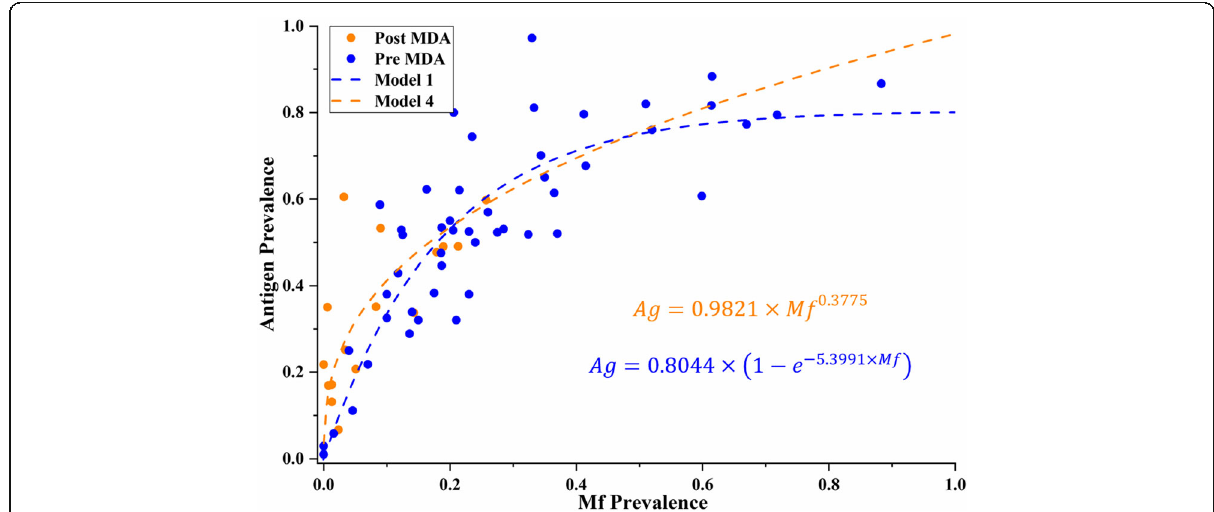
Fig. 2 Relationship between antigen and Mf prevalence predicted by models A1 (pre-MDA) and A4 (post-MDA). These combined models result in a “ diverging ” predictive relationship between diagnostic tests as Mf prevalence increases